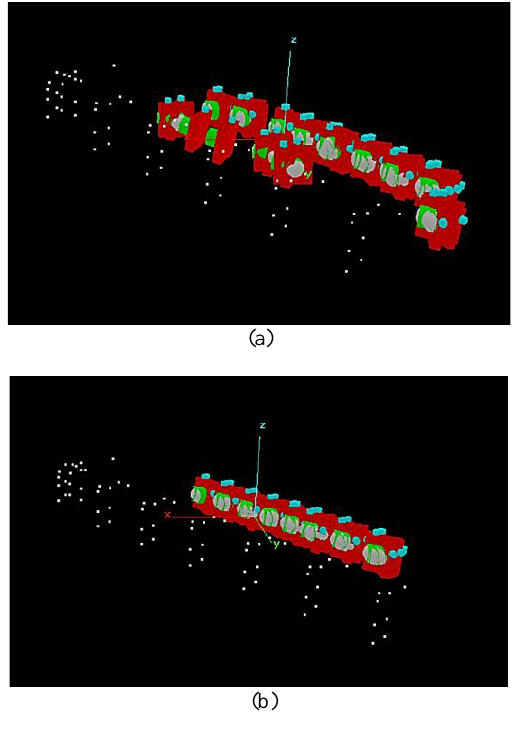
Figure 15. The position of the camera resulting from the resection process in (a) session 1 and (b) session 2 The next step is to do the bundle adjustment process. The data generated from the bundle adjustment process are the parameter values of the camera's external parameter that has been computed and the target points' coordinates. Furthermore, there is an RMS value in the bundle adjustment process and a sigma naught value.